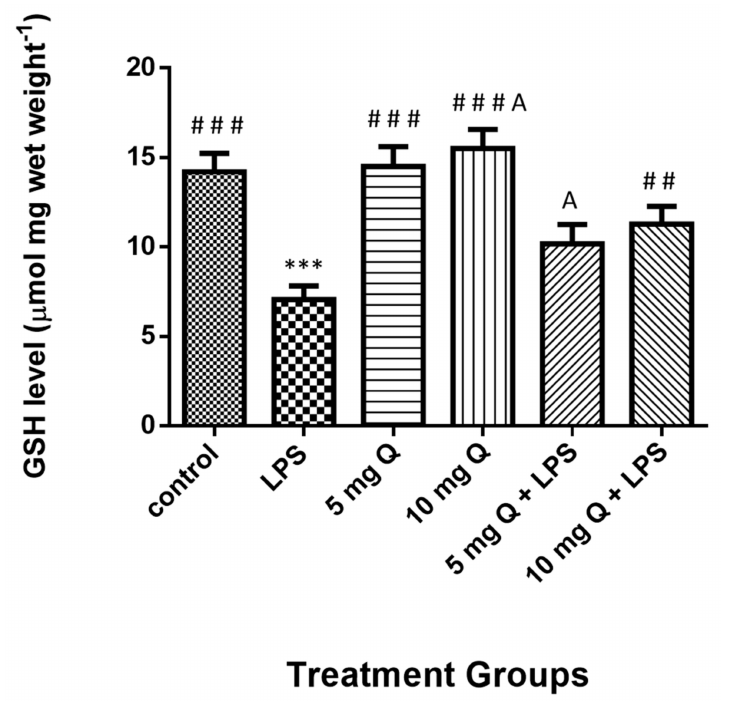
Figure 6. Treatment e ff ects on the levels of glutathione level in mice liver homogenate. Data represent the means ± standard error (SE), n = 10. * Significantly di ff erent from the control group; # Significantly di ff erent from the LPS group, A significant di ff erence between hesperidin 10 mg versus hesperidin (5 mg +